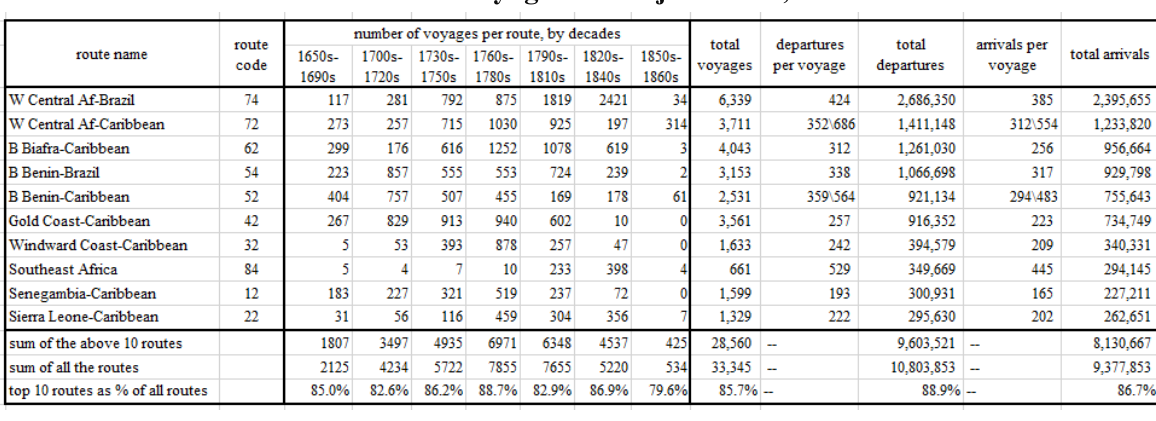
Table 5. Number of voyages for major routes,